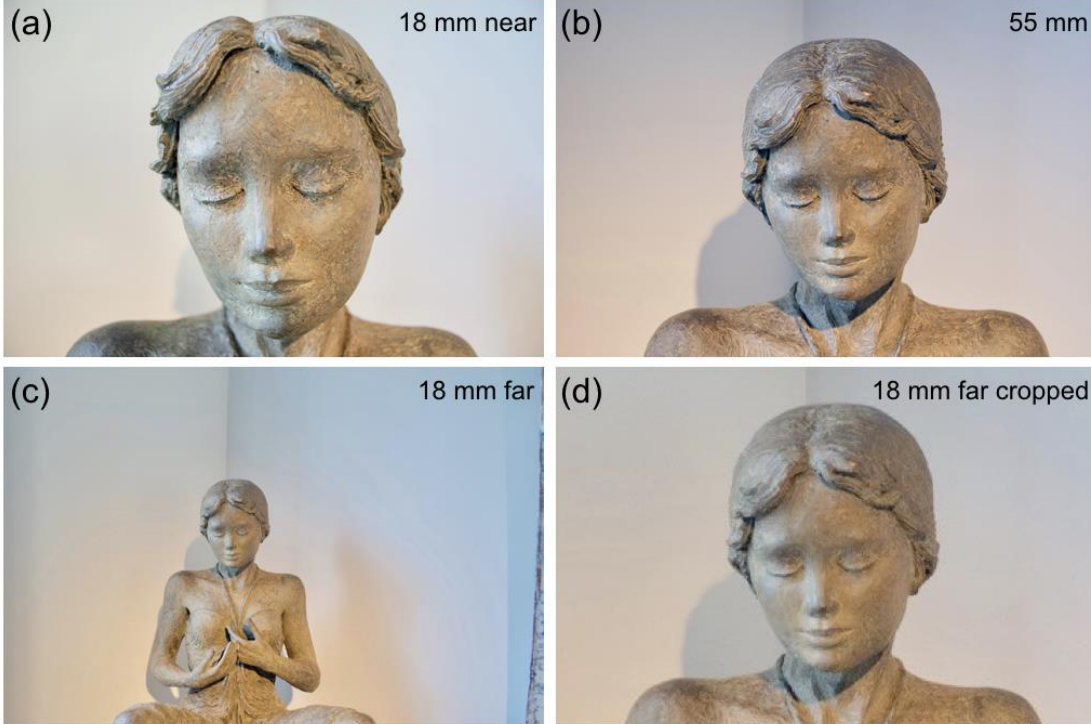
Figure 9. Four pictures of a bronze sculpture of a girl. The camera is fitted with an APS-C sensor. ( a ) Picture taken with an 18 mm lens from a near camera position. ( b ) Picture taken with a 55 mm lens from a far camera position. ( c ) Picture taken with an 18 mm lens from the far camera position of ( b ). ( d ) Picture ( c ), but cropped and expanded to match the size of the face in the other pictures.